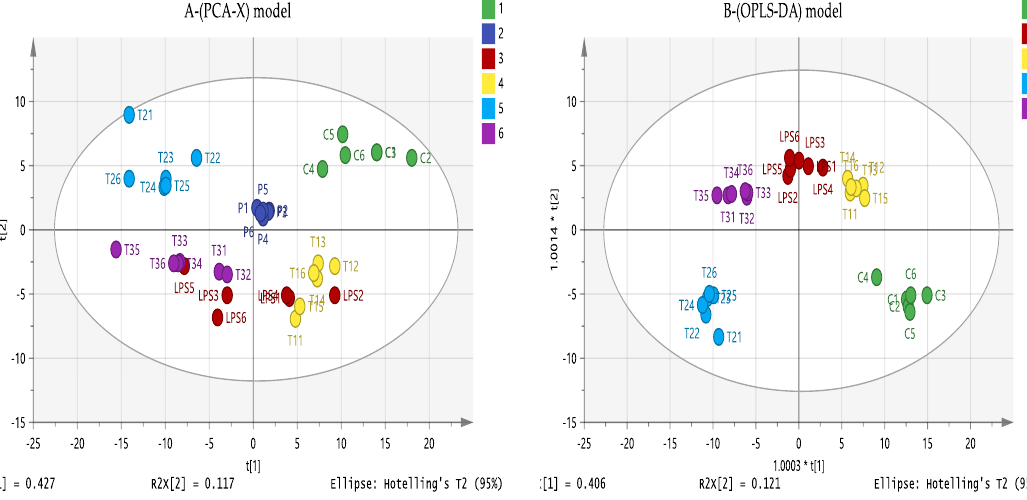
Figure 7. ( A ) Principle component analysis (PCA-X) vs. ( B ) Orthogonal Partial Least Squares Discriminant Analysis (OPLS-DA) score plots of THP-1 cells. The figures show a clear separation between control, pooled and treatment groups based on 358 polar metabolites separated on a ZIC-pHILIC column ( n = 6). PCA score plot (A) gives the goodness of fit (R 2 X) = 0.807, and the goodness of prediction (Q 2 ) = 0.641. OPLS-DA score plot (B) gives R 2 X = 0.829, R 2 Y = 0.962, Q 2 = 0.874.